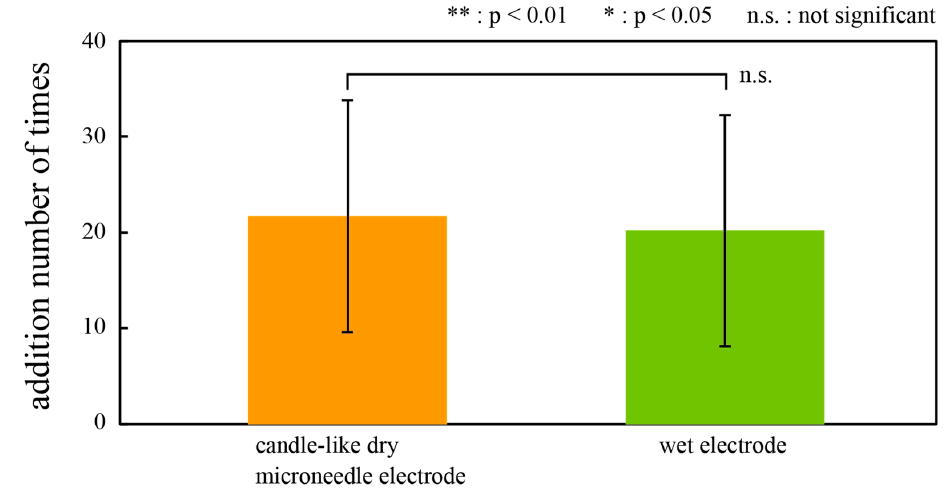
Figure 7. The amplitudes of the grand mean wave after the latency time to the deviant and standard stimuli with ( a ) CMEs and ( b ) the wet electrodes. Significant differences between the stimuli were obtained for both electrodes. Error bars: the standard deviation. Micromachines 2020 , 11 , x FOR PEER REVIEW